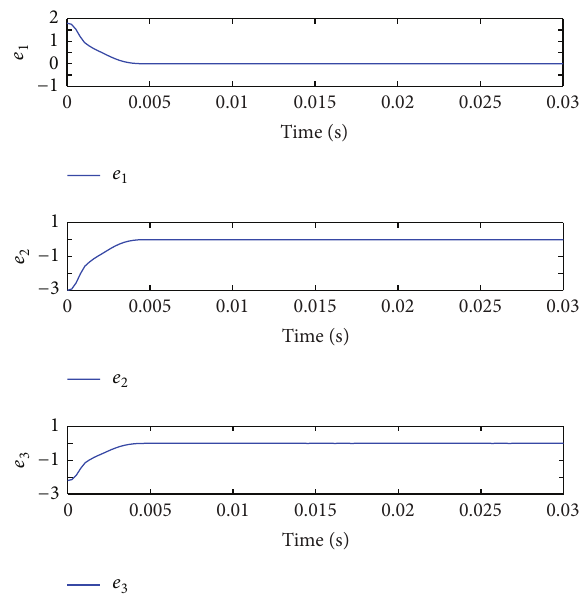
Figure 12: State responses of the error system.